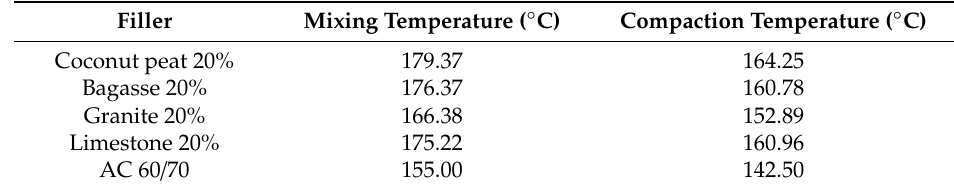
Table 5. Mixing and compaction temperature of asphalt mixture with di ff erent asphalt mastic type using the asphalt binder viscosity criteria.